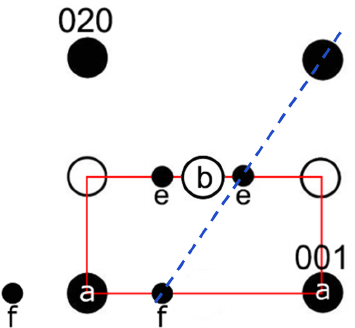
Figure 1. Schematic drawing of a reflection arrangement along the zone axis [100]. The labradorite cell, which is displayed in red, is simplified (90 ◦ angle and distances not to absolute scale). The f - reflections occur around the a -reflections, while the e -reflections occur around absent b -reflections. The satellites are connected with the a -reflections in a straight line (dashed blue